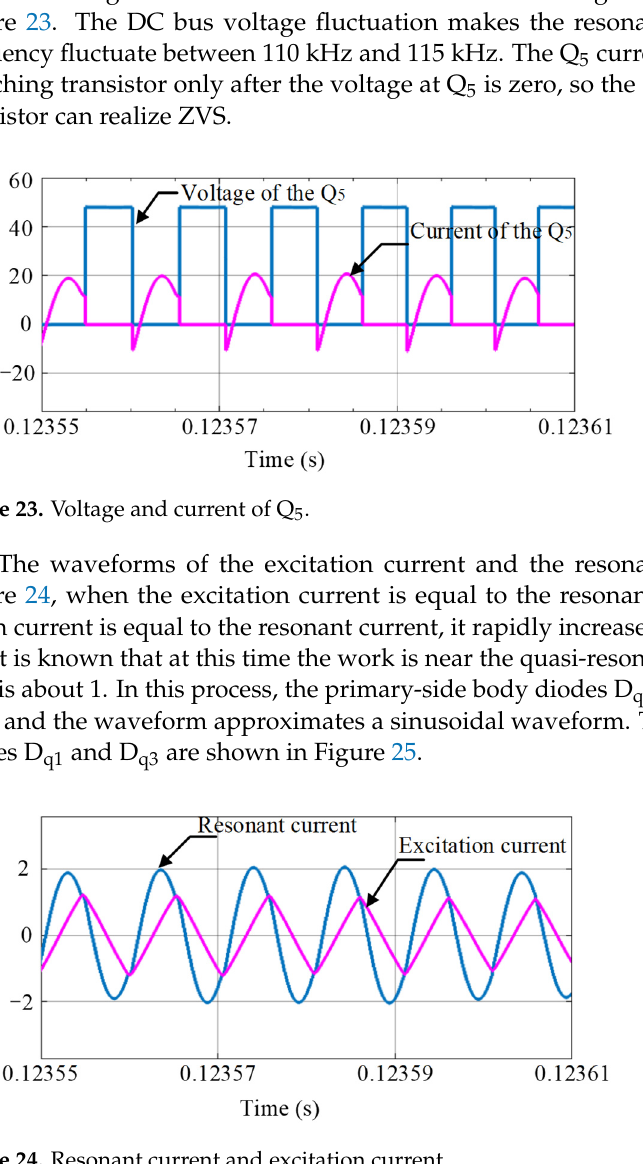
Figure 24. Resonant current and excitation current.